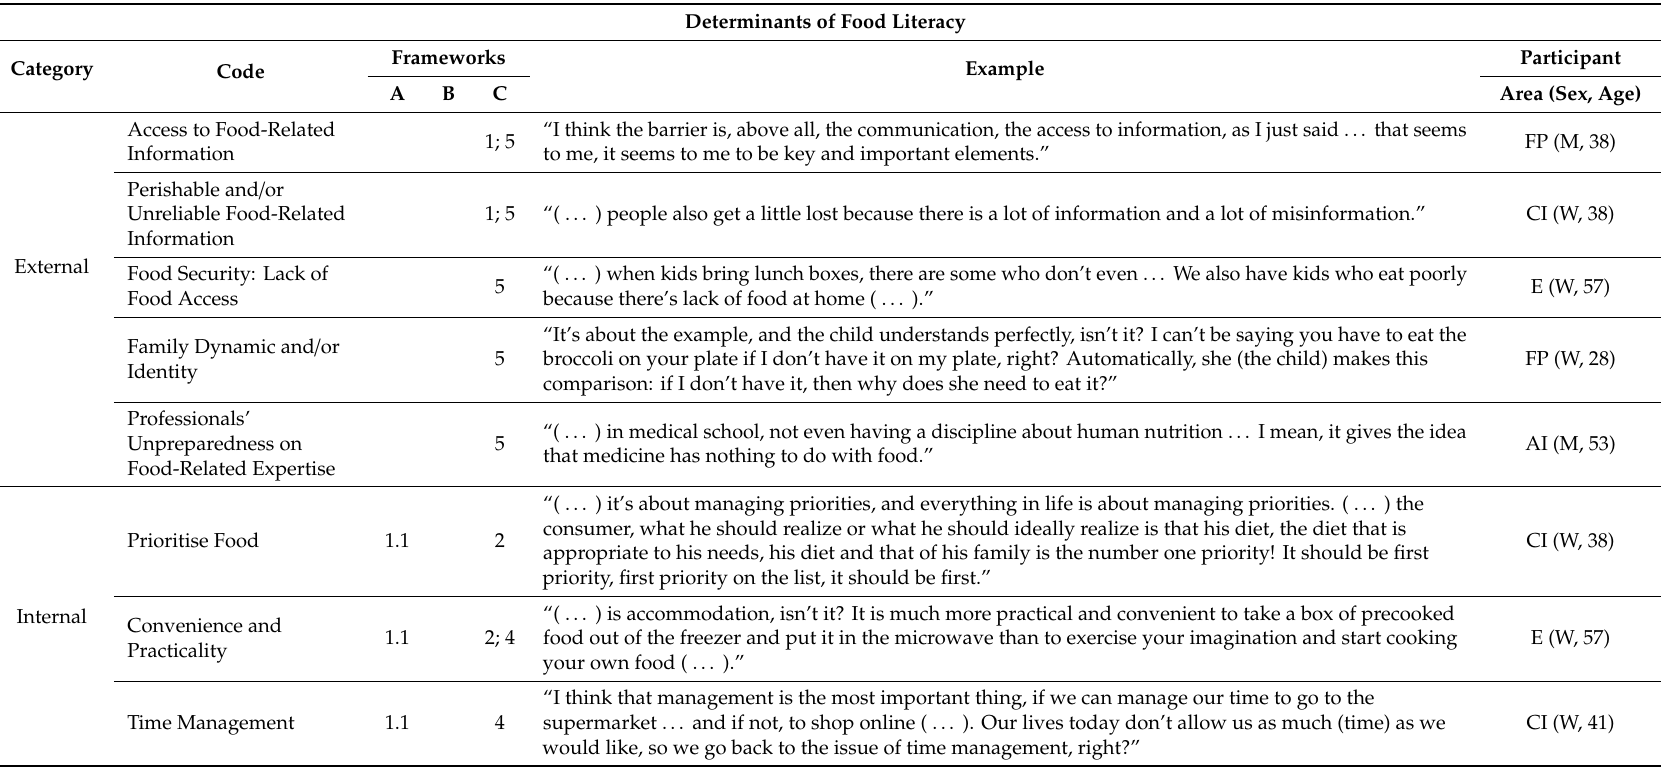
Table 4. Representation of the theme “Determinants of Food Literacy”, its categories and concerning attributes (codes), the coding against conceptual frameworks [3,13,24], an exemplifying quote and its respective author’s professional and demographic